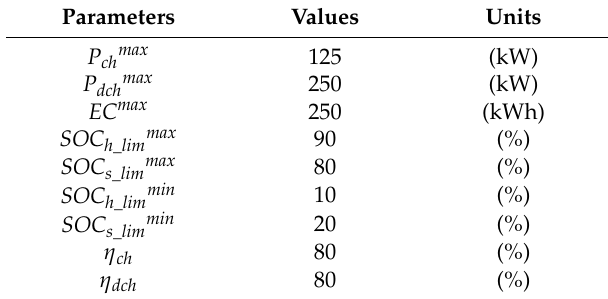
Table 3. ESS parameters.